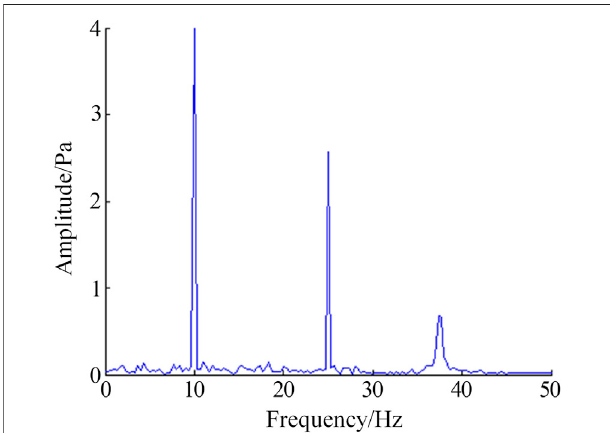
FIGURE 7 | Spectrum of the signal after denoising by wavelet.